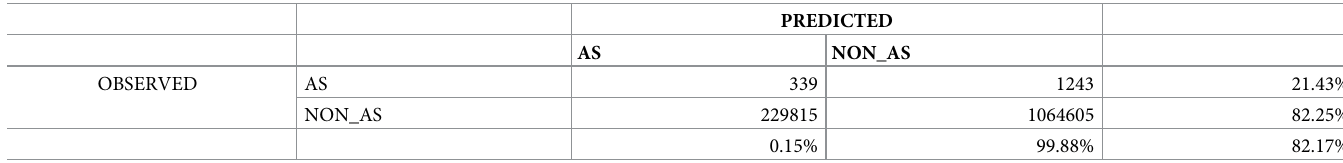
Table 3. Male excluding training and testing data.